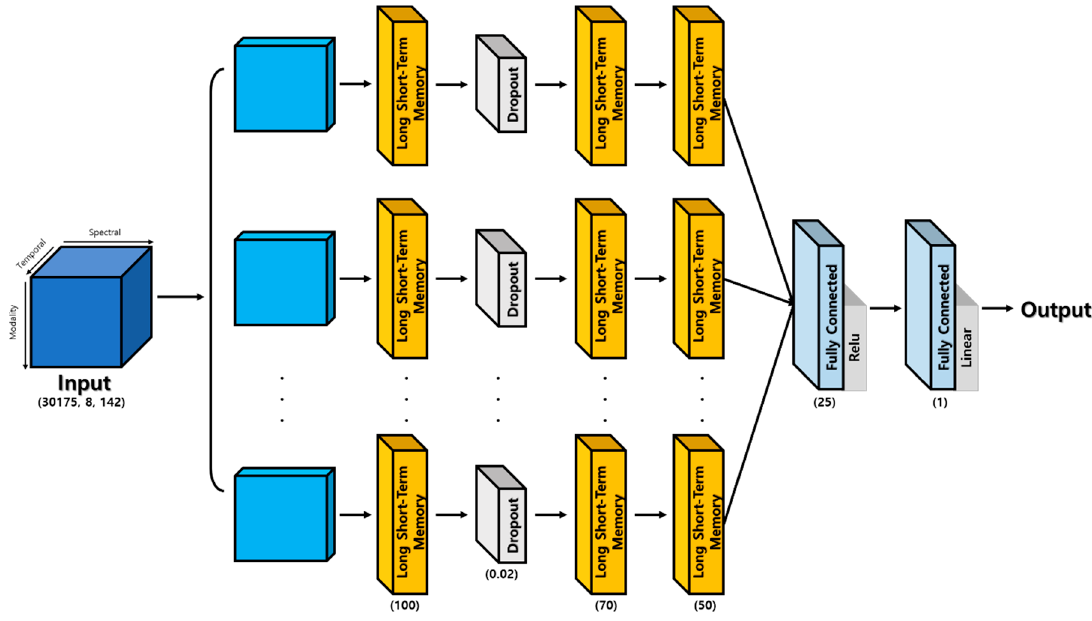
Figure 7. LSTM-fully connected (FC) model architecture.